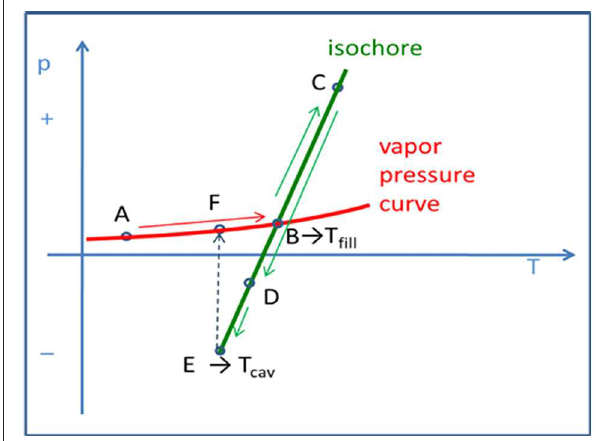
FIGURE 10 | The Berthelot cycle used to obtain tensioning in the IL samples inside a glass capillary: liquid at L-V equilibrium (A) ; the liquid fills in the entire internal volume at Tfill (B) ; the liquid is forced along an isochore (constant volume) creating higher, positive pressures (C) ; if the liquid adheres extremely well to the glass capillary walls, at point (D) the liquid is experiencing an isotropic, bulk tension (absolute negative pressure metastable state). At Tcav (cavitation temperature) it will collapse at point (E) , relaxing back to its stable condition located along its vapor pressure curve at (F) . (Reprinted from Silva et al., 2018 ).